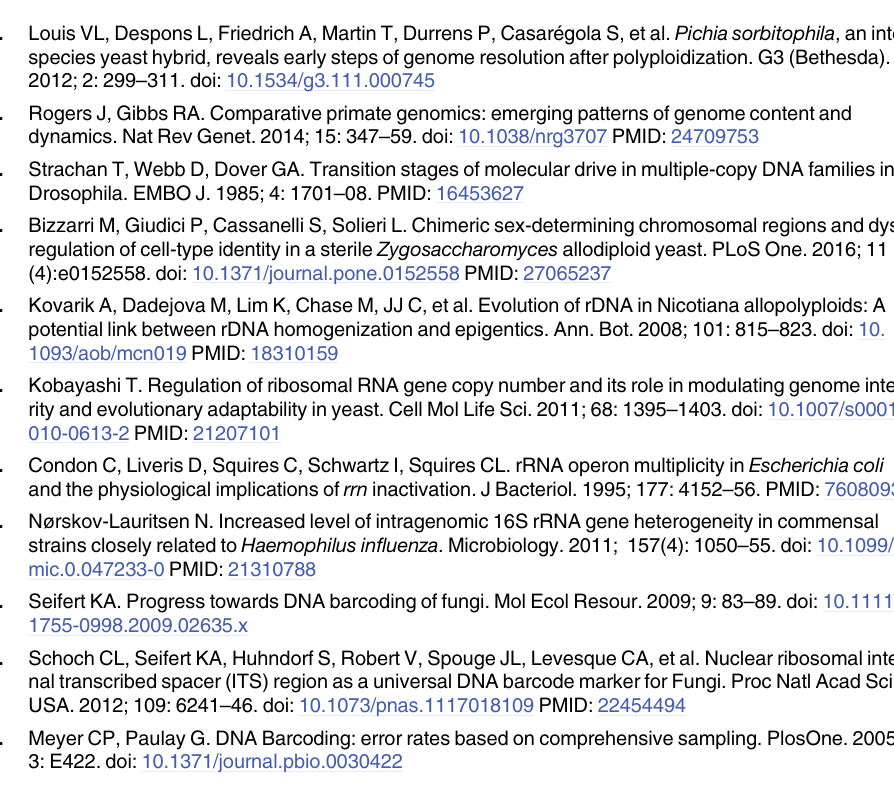
PLOS ONE | DOI:10.1371/journal.pone.0160744 August 8,